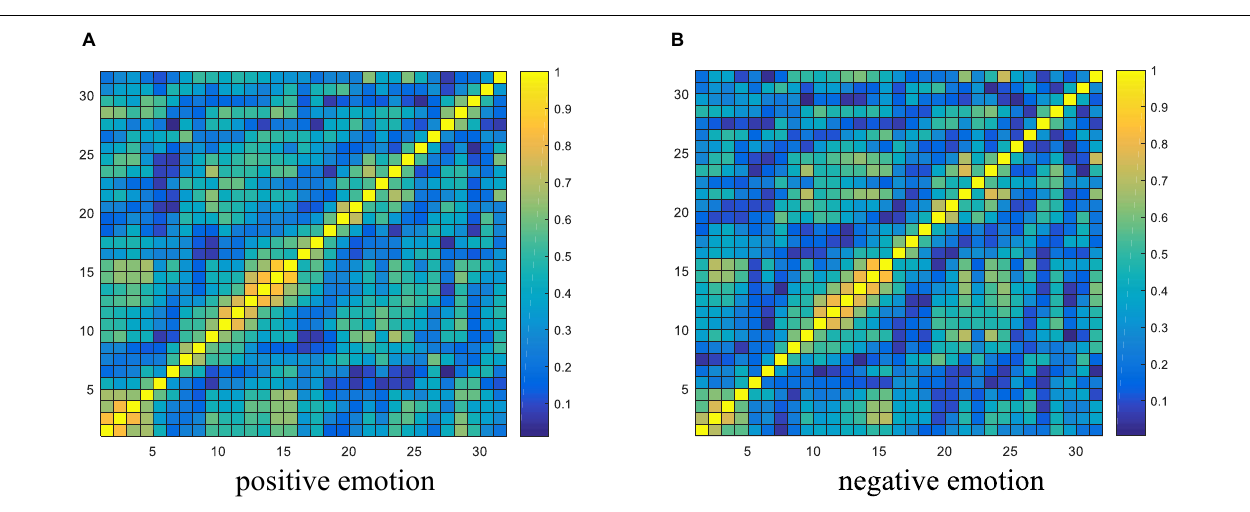
FIGURE 11 | Visualization of PLV connectivity features. (A,B) Respectively shows the average PLV connectivity pattern under the positive and negative